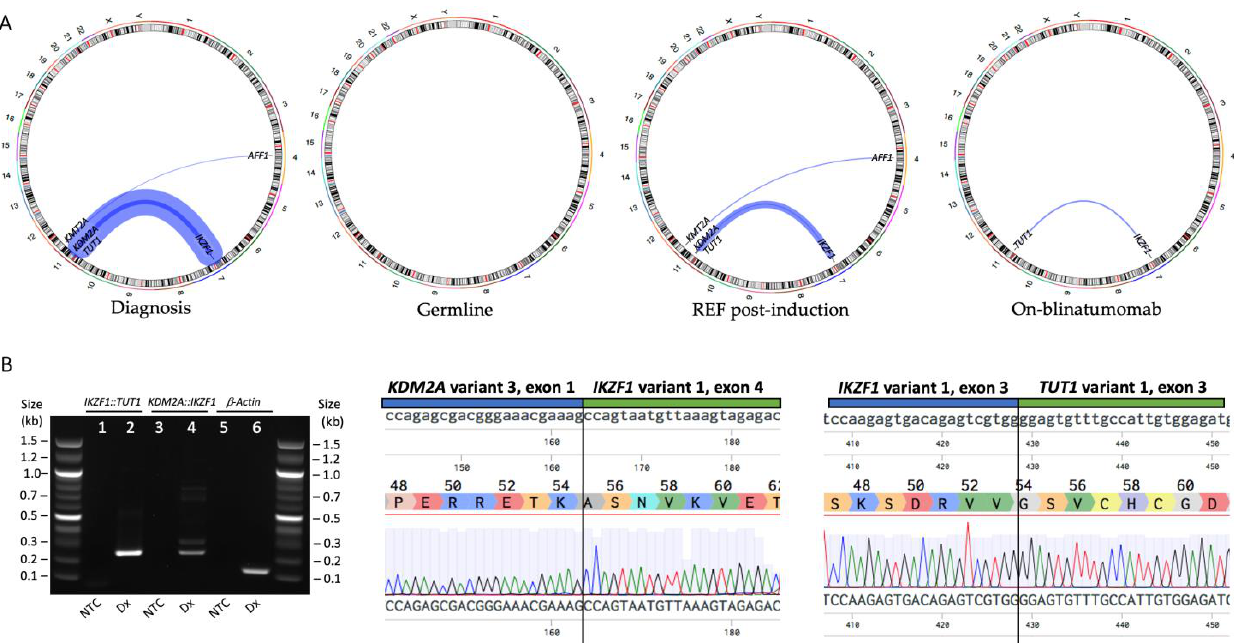
Figure 2. ( A ) Circos plot representation of gene fusions identified by transcriptomic sequencing of PBMNC at diagnosis, MSC representing a germline sample, BMMNC from a refractory sample after